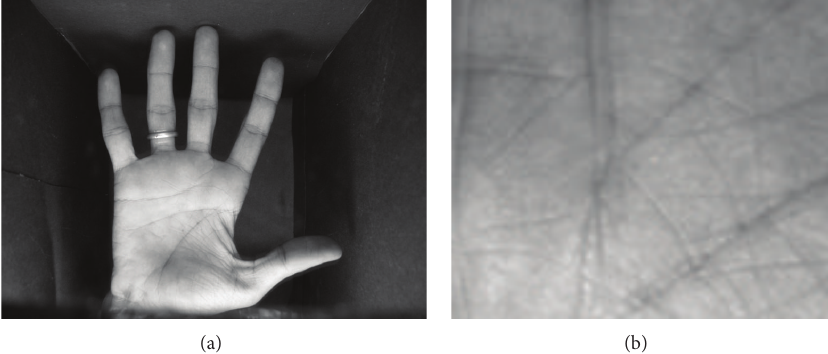
Figure 4: (a) Sample input image. (b) ROI image for IIT Delhi palmprint